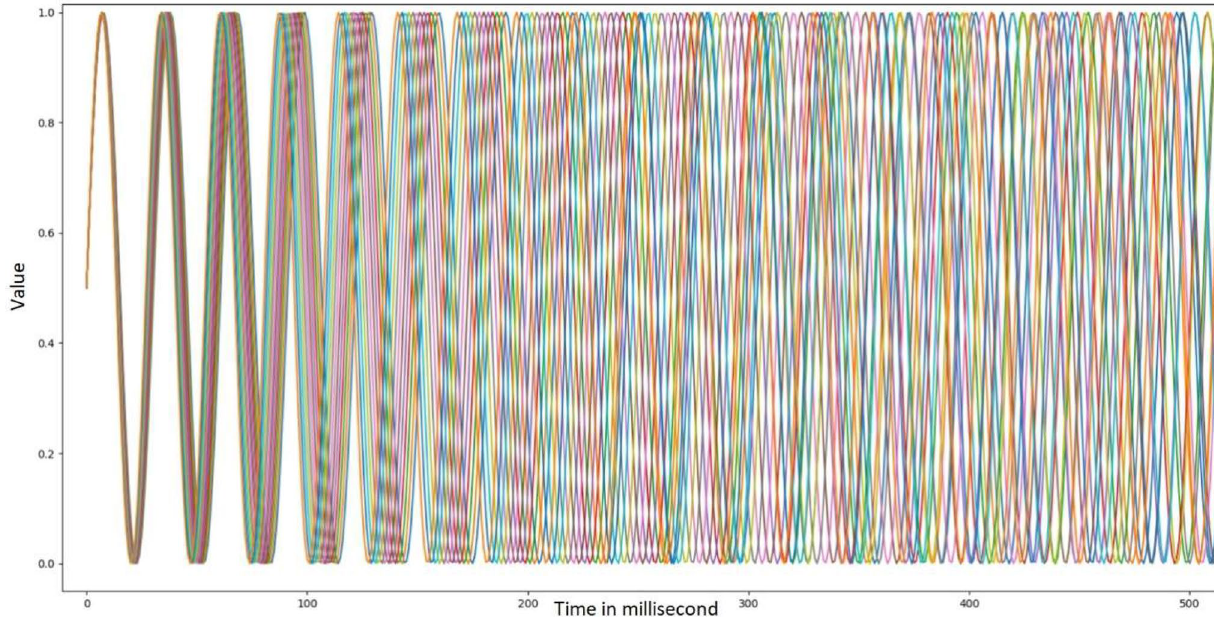
Figure 2. Representation of oscillation value for each